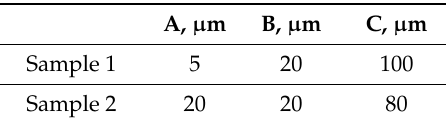
Figure 10. The experimental sample design ( a ) and two methods for powering and signal readout ( b ). Table 1. Electrode cell